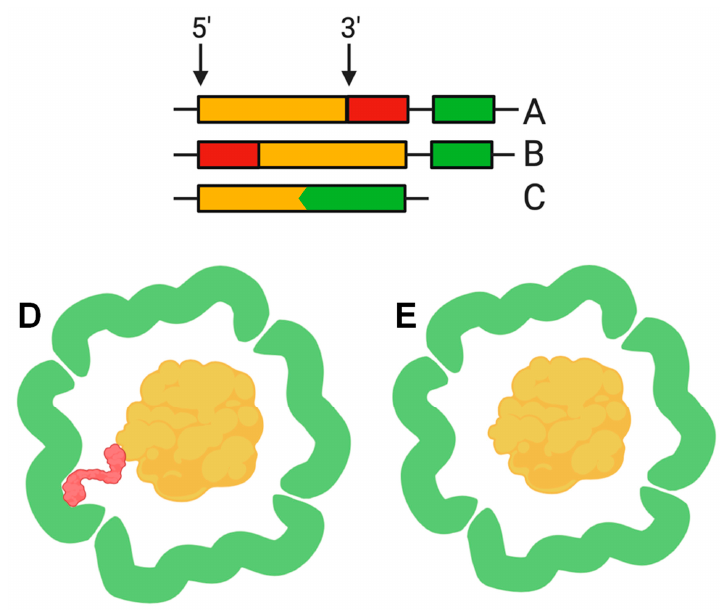
Figure 2. The cargo loading peptide coding sequence can be located at either the 5 ′ or 3 ′ end of the cargo loading peptide gene ( A , B ) with formation of the encapsulin structure ( D ). In some cases, the cargo protein encoding gene and encapsulin shell encoding gene are fused ( C ), and there is no need for a cargo-loading peptide to form encapsulin structure ( E